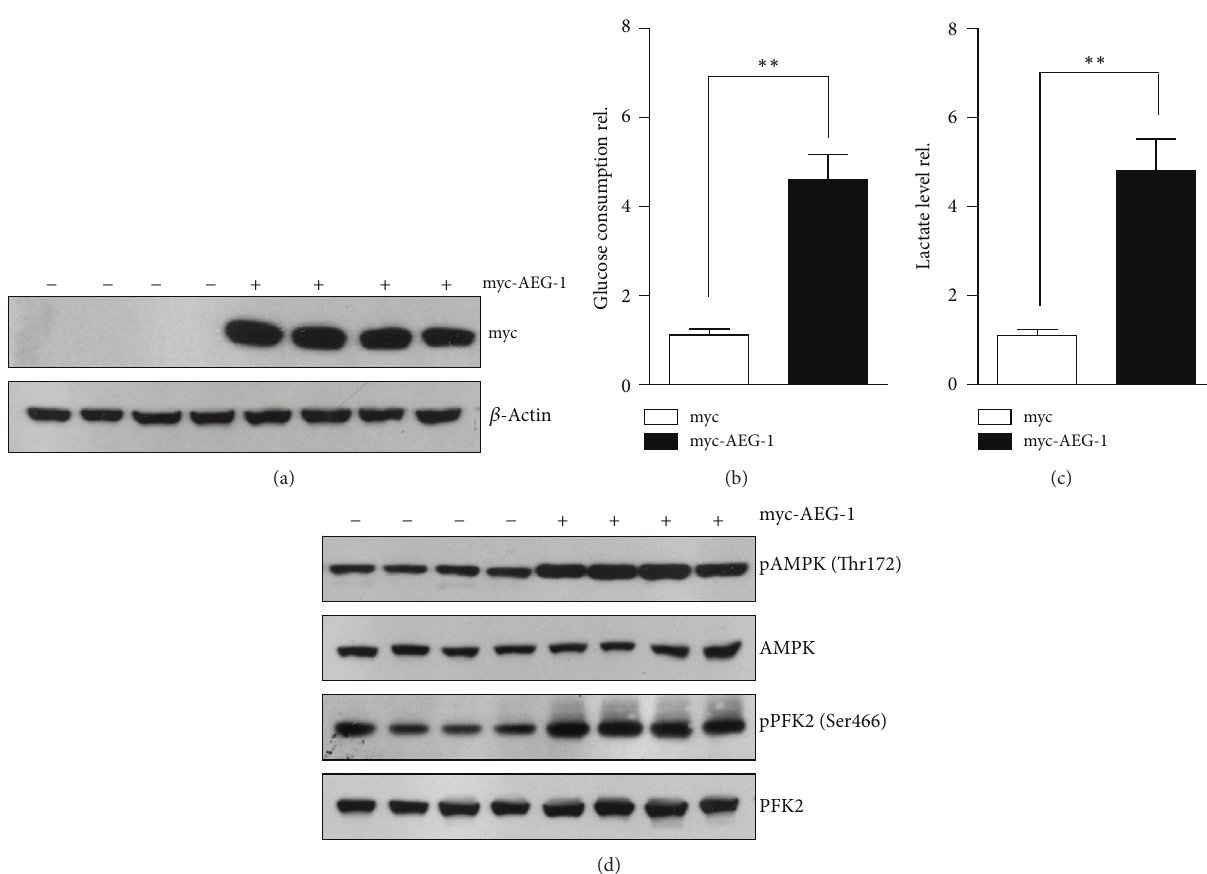
Figure 2: AEG-1 promoted anaerobic glycolysis via AMPK in NCM460 human colonic epithelial cells. (a) Western blots showing the overexpressionofmyc-AEG-1proteinsinNCM460cells.((b)-(c))Biochemicalassaysshowingtheincreasingofglucoseconsumptions(b)and lactateproductions(c)inAEG-1-overexpressedNCM460cells,incontrasttocontrols.Resultswereaveragesoffourindependentexperiments. Data represent mean ± SEM. ∗∗ 𝑃 < 0.01 . (d) Western blots showing that AMPK phosphorylation and PFK2 phosphorylation were increased in AEG-1 overexpressed NCM460 cells. It is noted that the total AMPK or PFK2 protein levels were not altered by AEG-1 overexpression.